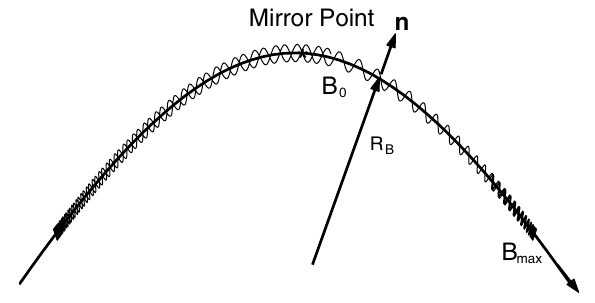
FIG. 14. Motion of electron in a mirror magnetic field.